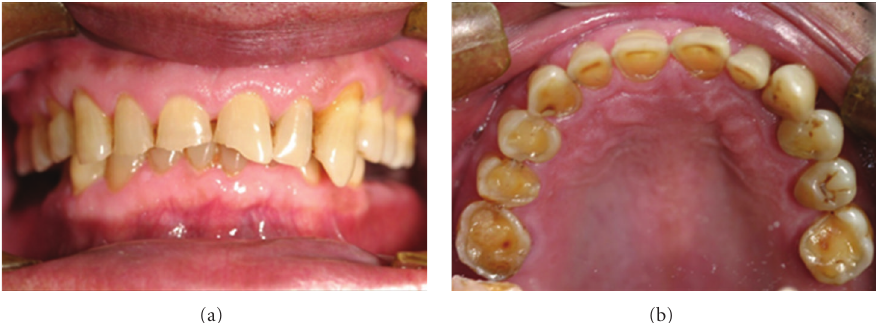
Figure 3: Frontal and maxillary occlusal views of severe tooth erosion caused by endogenous acid in a patient with GERD. (Courtesy of Dr. A.